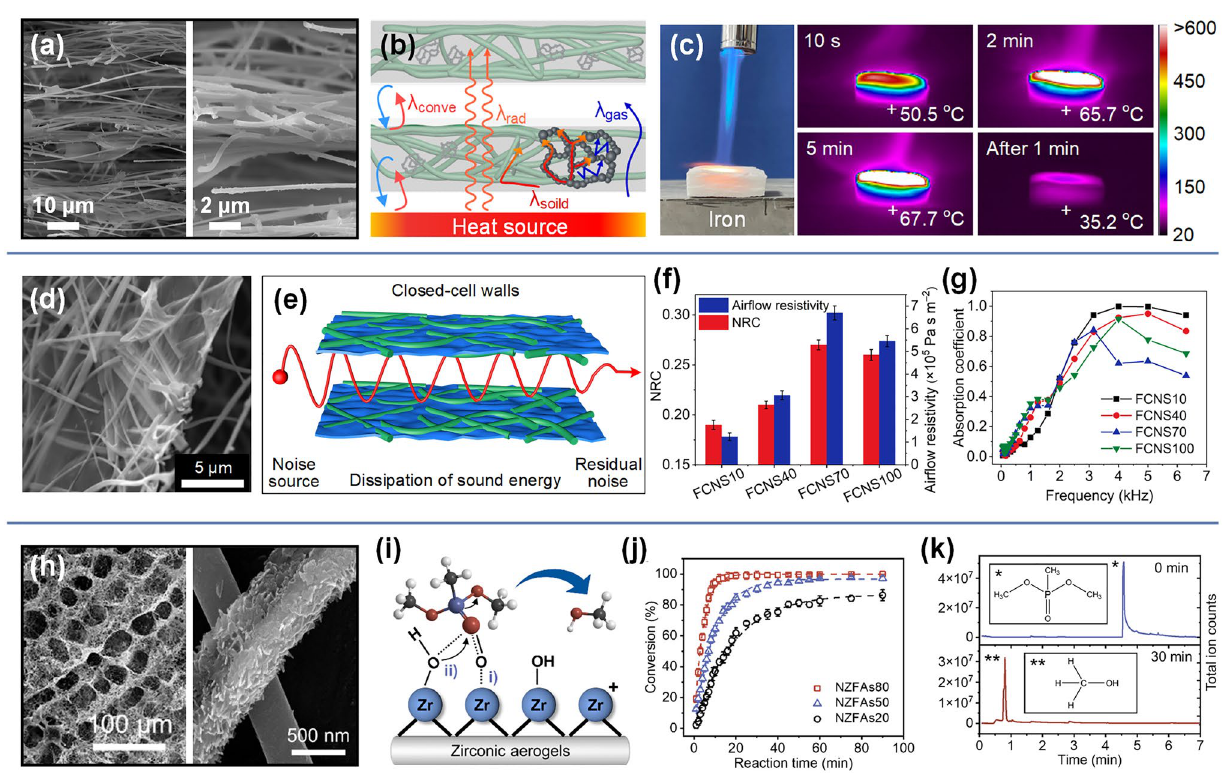
Fig. 9 a SEM image of ZrO 2 ‑SiO 2 nanofibrous aerogel showing its hierarchical structure [171]. b Schematic demonstration of factors contribut‑ ing to thermal conductivity of the ZrO 2 ‑SiO 2 nanofibrous aerogel [171]. c Optical and infrared thermal images showing temperature distribu‑ tions of the aerogel jetted by a butane flame [171]. Copyright 2022, American Chemical Society. d SEM image of ceramic nanofibrous aerogels exhibiting the hierarchically entangled networks [172]. e Schematic illustration of the sound absorption mechanism for closed cell walls [172]. f Effects of GO loading amount on noise reduction coefficient (NRC) and airflow resistance of the aerogel [172]. g Variation of the absorption coefficient of the relevant aerogels [172]. Copyright 2021, Springer Nature. h SEM image of Zr(OH) 4 @PVB/SiO 2 nanofibrous aerogel showing its hierarchical structure [174]. i Mechanism of DMMP degradation by aerogel [174]. j Plots of DMMP conversion versus reaction time [174]. k Extracted chromatograms for the initial and 30 min DMMP challenges the aerogel. The inset is the molecular formula of the chemical substance of labeled peaks [174]. Copyright 2021, American Chemical